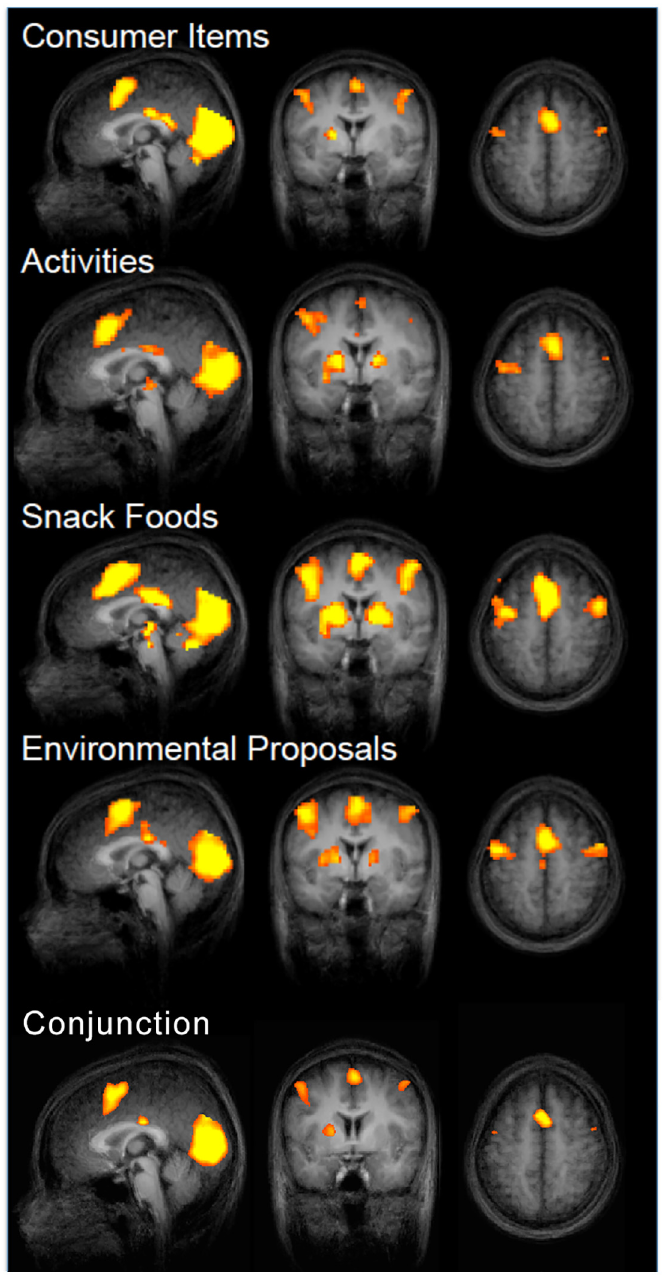
posterior cingulate cortex (PCC), ventral striatum, visual cortical areas, and superior frontal